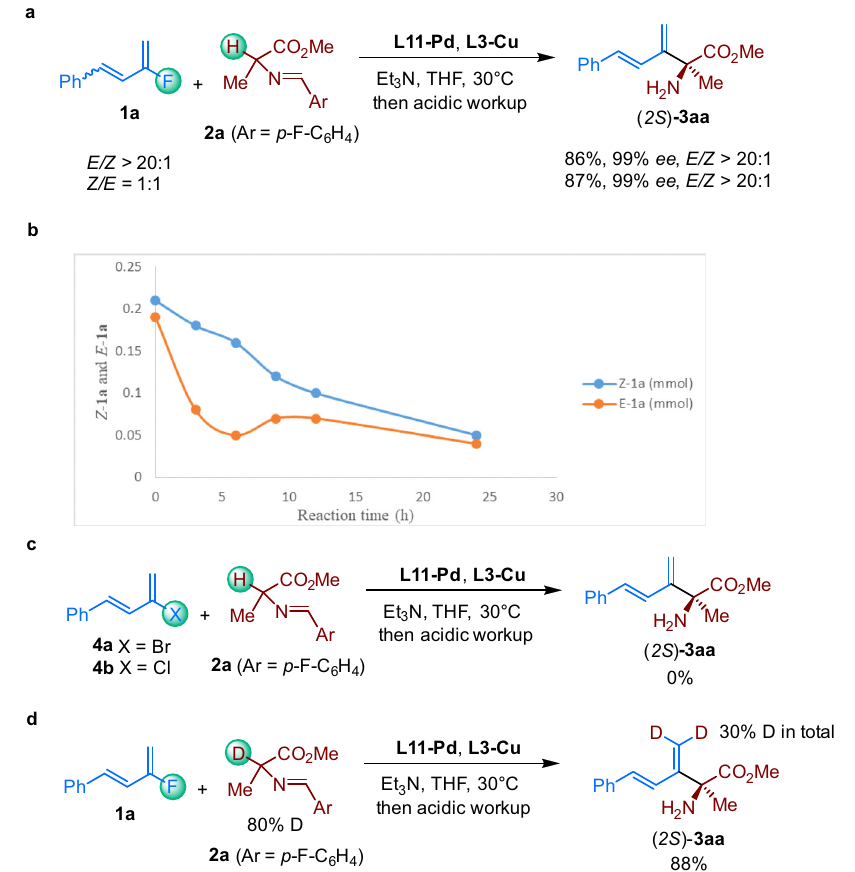
Fig. 5 Control experiments. a Relationship between the ratio of Z / E - 1a and ratio of Z / E - 3aa . b The absolute amount the Z- 1a and E - 1a during the reaction. c Reaction of dienyl bromide 4a or dienyl chloride 4b under the standard conditions. d Deuterium atom scramble experiment.